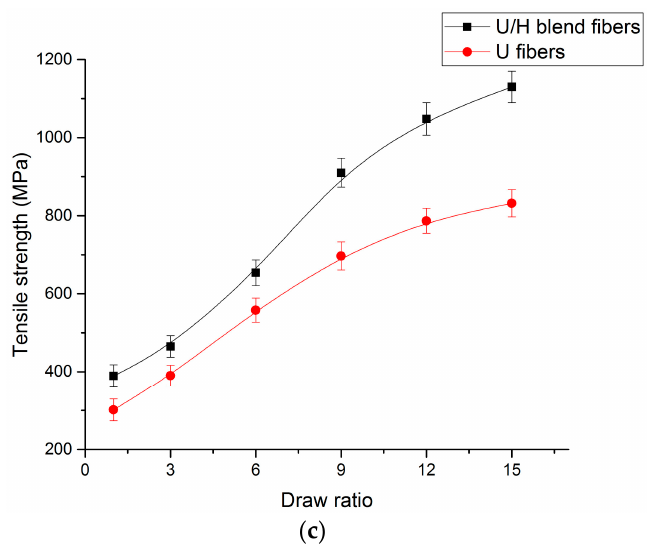
Figure 14. Mechanical properties of fibers: ( a ) elongation at break; ( b ) initial modulus; and ( c ) tensile strength.